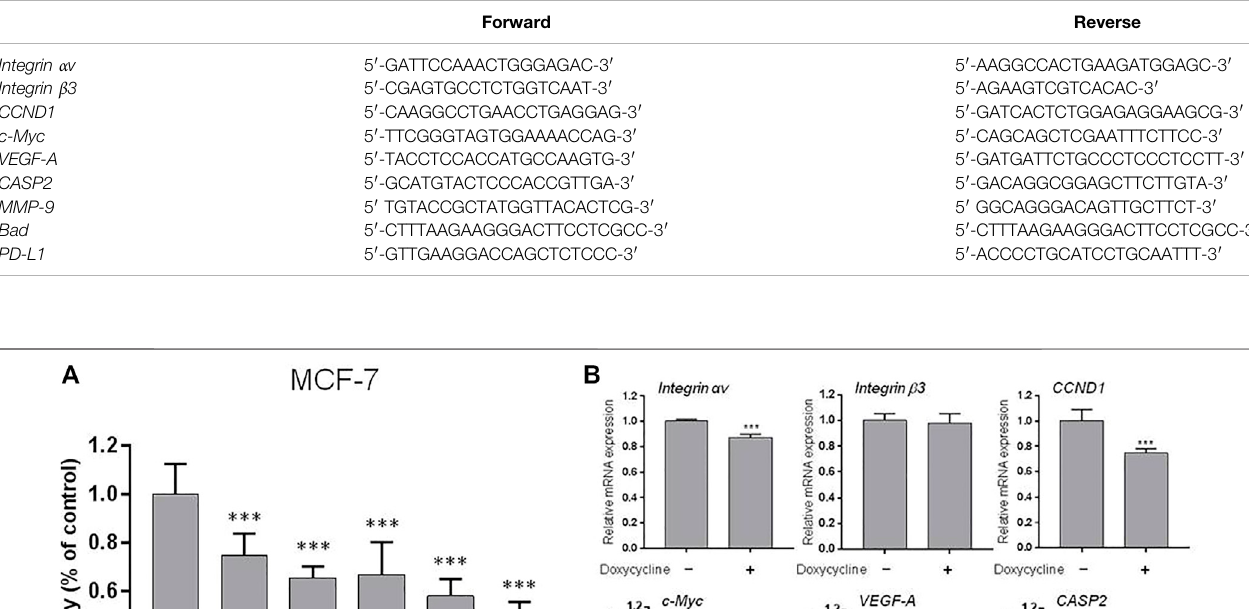
TABLE 1 | Primer sequences for the qPCR.